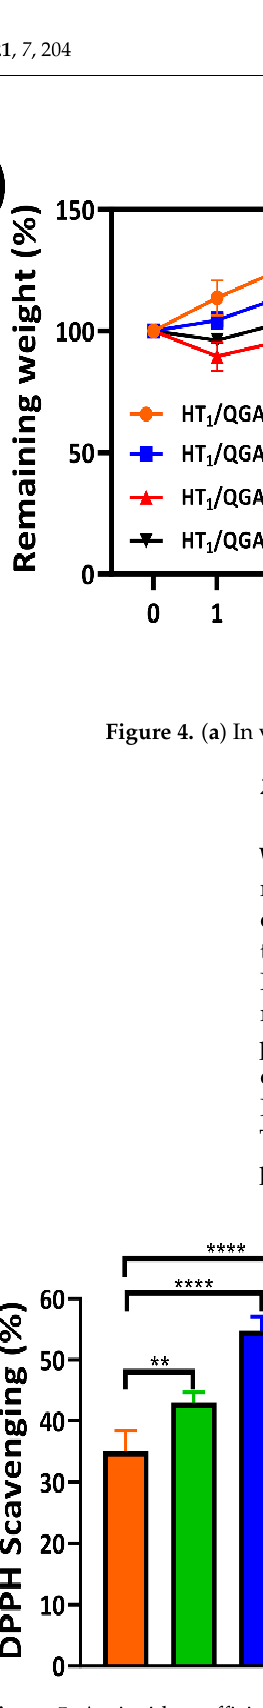
Figure 5. Antioxidant efficiency of HT/QGA hydrogel. ( a ) DPPH radicals’ and ( b ) hydroxyl radicals’ scavenging ability in hydrogel. ** p < 0.01, **** p < 0.0001, mean ± SD, n = 3.